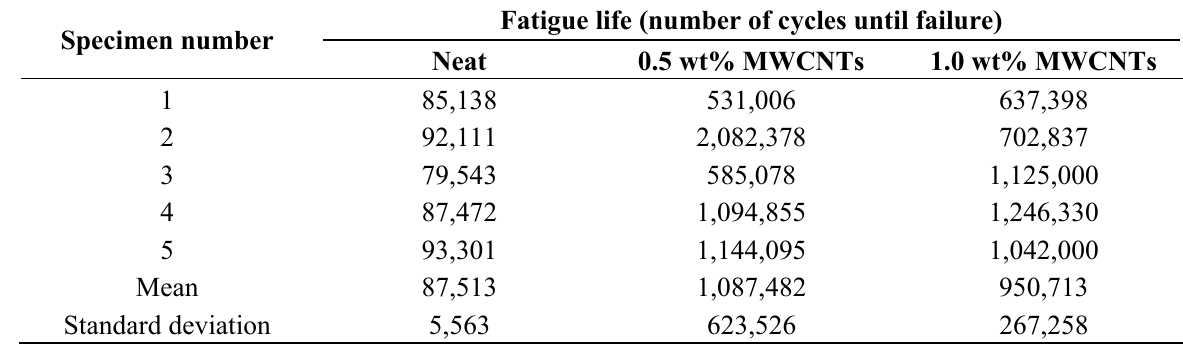
Table 2. Fatigue life (Number of cycles until failure) for individual GFRP